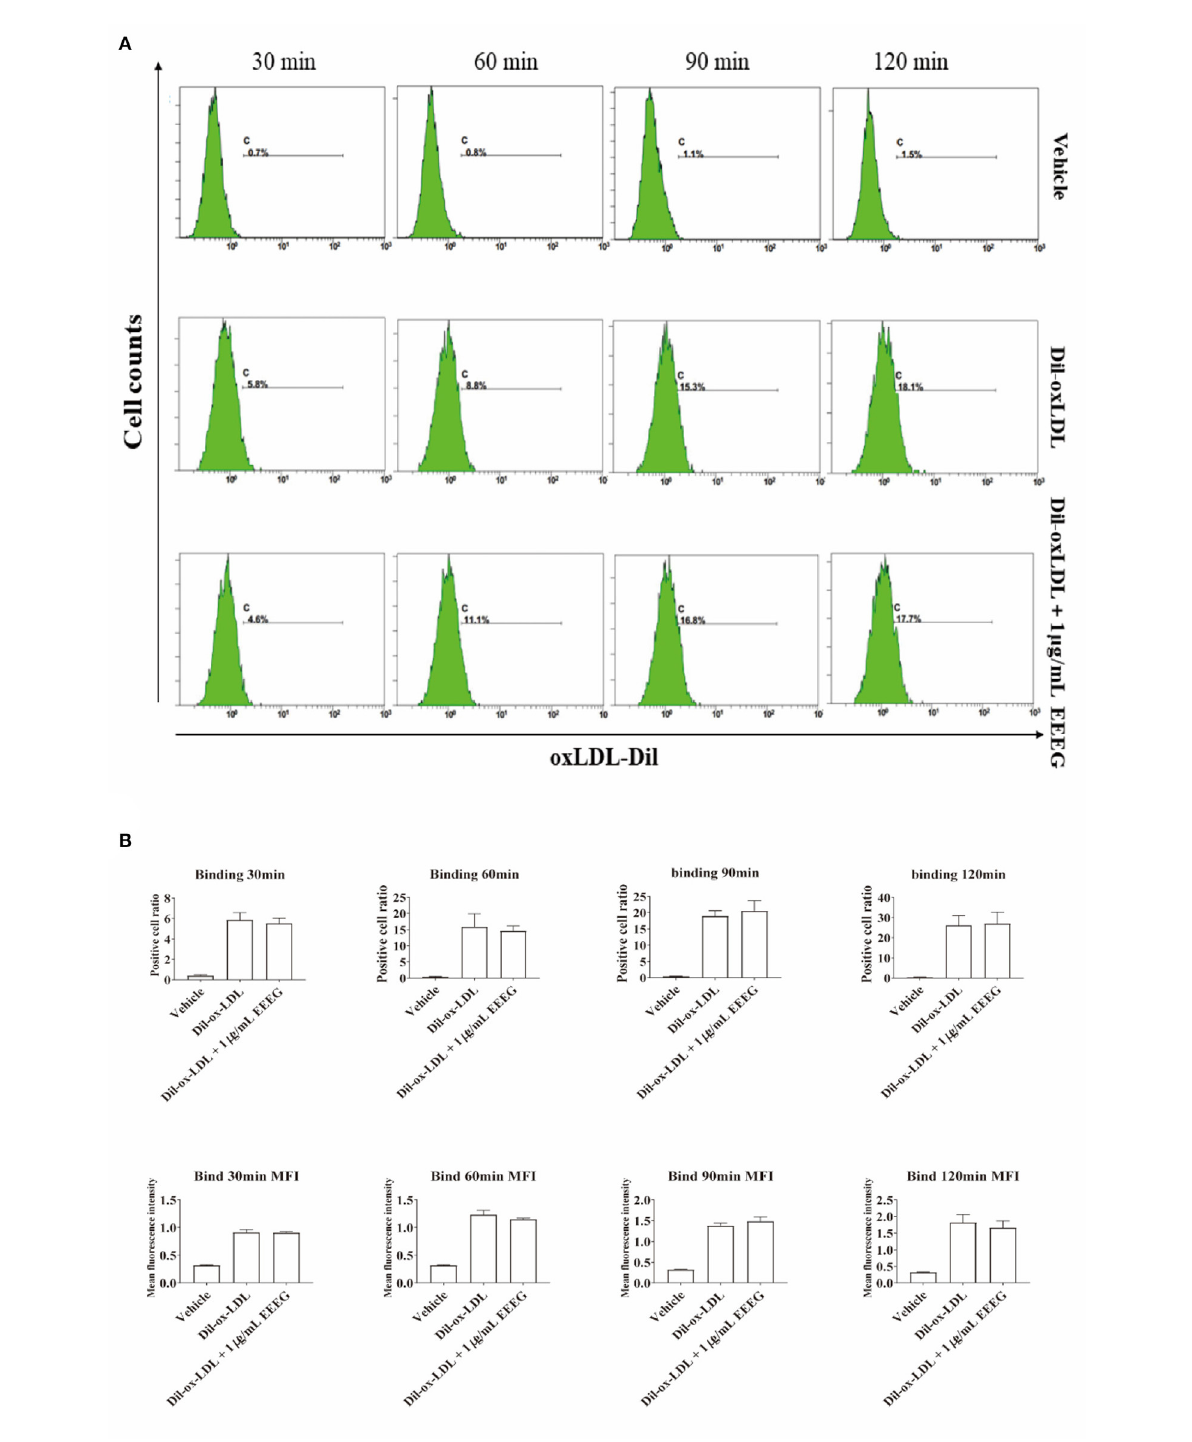
FIGURE2 EEEG treatment does not influence the surface-binding of oxLDL to macrophages. (A) Representative histogram plots of Dil-ox-LDL binding by macrophages. Cells were incubated for 30, 60, and 90min with Dil-ox-LDL in the presence or absence of EEEG, followed by flow cytometry. (B) Quantification of the percentage of positive cells and mean fluorescence intensity values. DiI-ox-LDL-fluorescence is shown on the Y-axis and macrophages on the X-axis. Data are expressed as mean ± s.e.m., Statistical analysis was based on Graphpad Prism 9.0.2 software and a value of P < 0.05 was considered statistically significant. One-way ANOVA with Student Neuman-Keuls post-hoc test was performed to compare the data between multiple